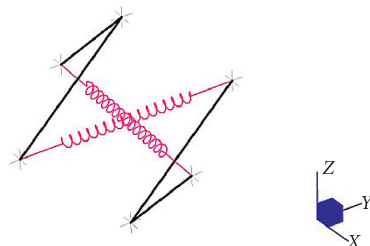
Figure 13: Octahedron